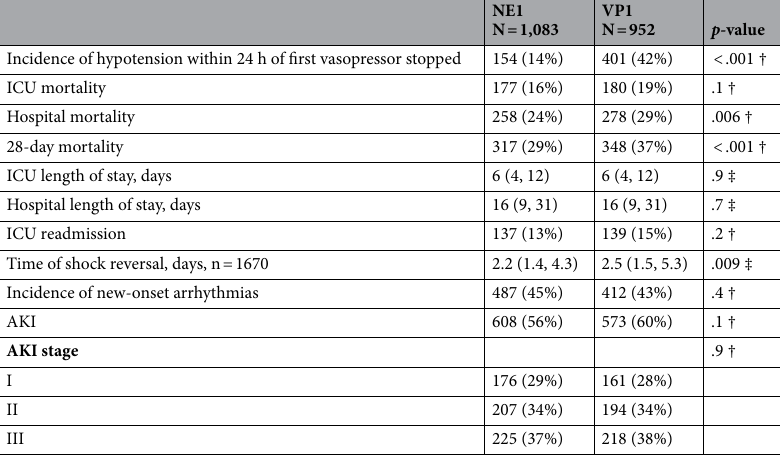
Table 2. Clinical outcomes of all shock patients. Numbers indicate N (%) and (minimum, maximum) unless otherwise noted. † Chi-square; ‡Wilcoxon rank-sum.